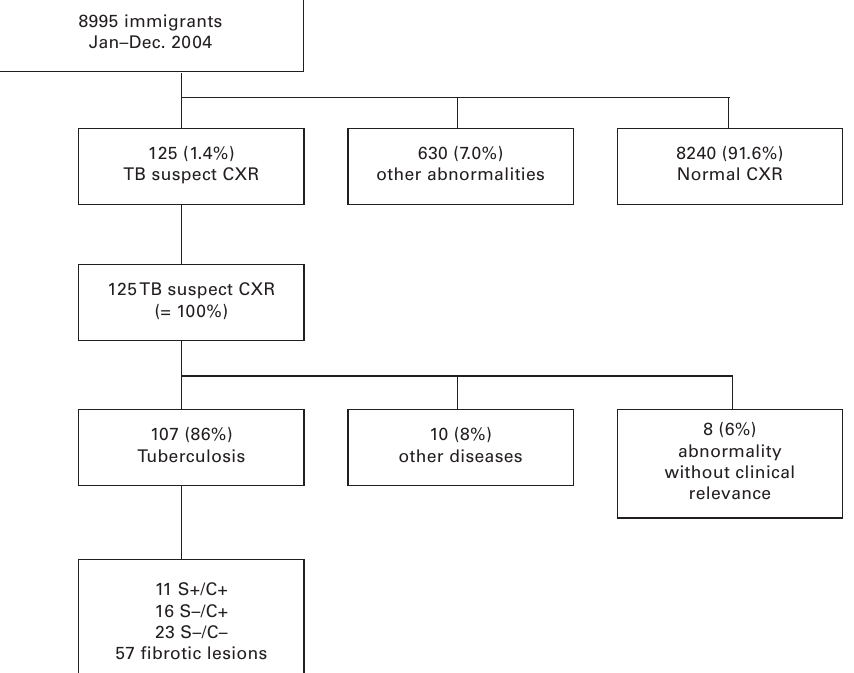
Flow chart of the study. CXR: Chest x-ray, S+ Smear positive, C+ culture